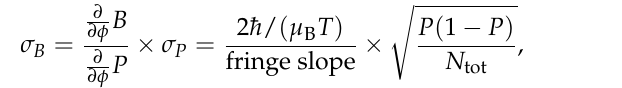
of detecting atoms at certain interferometer output, i.e., the phase behavior. Taking the calculated fringe slope of Equation (6), we can see from Figure 7 that preparing the initial state on | 2, 0 (cid:105) with 1 × 10 5 atoms, employing two π /2 pulses, and a free evolution time of 21 ms is enough to reach a one-shot resolution of 1.0 pT magnetic field. Under the